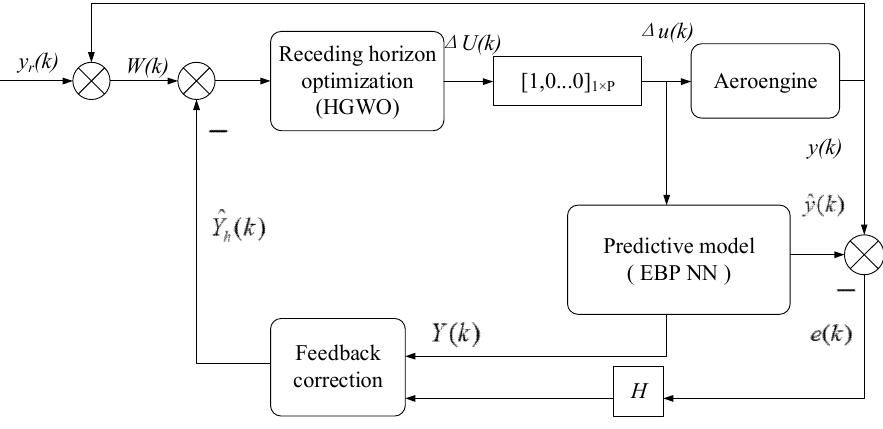
Figure 5. Nonlinear model predictive control (NMPC) schematic diagram.